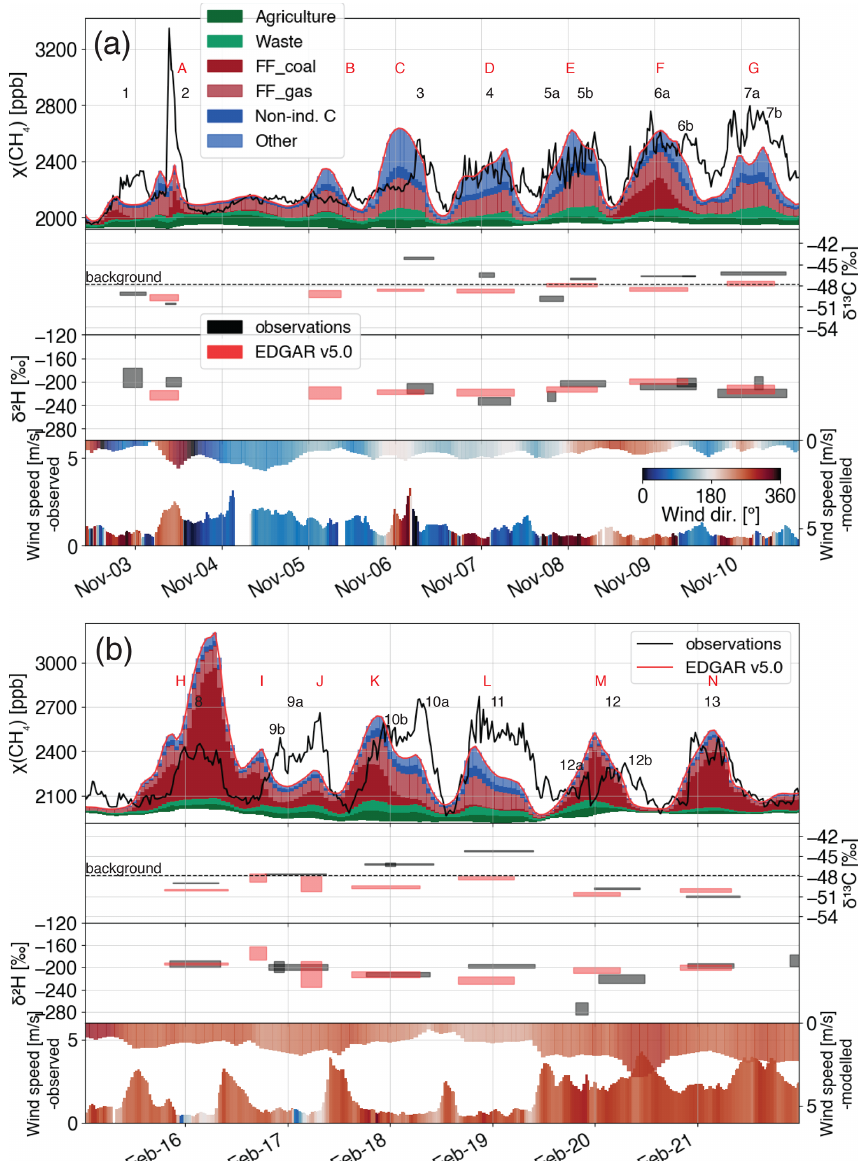
Figure 7. Detailed analysis of two subsets of the dataset: (a) from 2 to 10 November 2018 and (b) from 15 to 22 February 2019. Top panels: observed (grey) and modelled (red) mole fractions and relative source contributions from the EDGAR v5.0 inventory. FF denotes fossil fuel, and non-ind. C denotes non-industrial combustion. Middle panels: δ 13 C and δ 2 H source signatures of individual peaks of the observed (grey, from peak 1 to 13) and modelled (red, from peak A to N) time series. Box heights represent ± 1 σ of each peak isotopic signature. Bottom panels: wind speed and direction measured simultaneously at the study site (pointing up) and used for the CHIMERE simulations (pointing